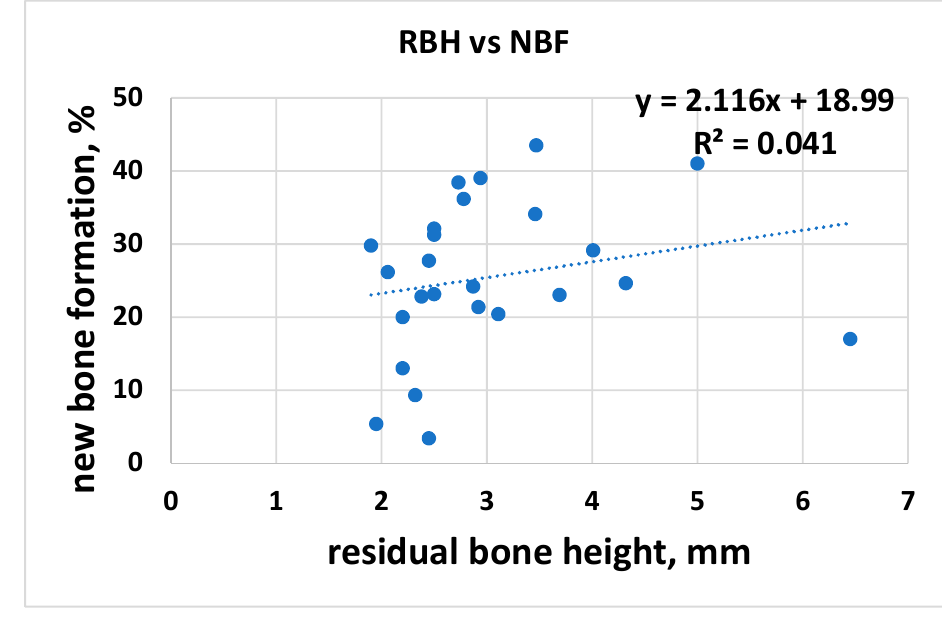
Figure 3. RBH and NBF.